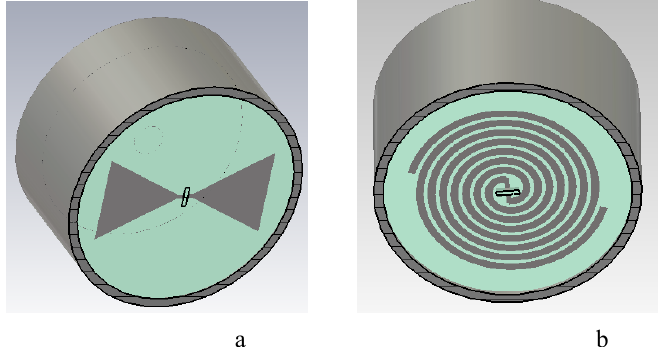
Fig. 2 . 3D model of a symmetrical dipole with triangular shoulders placed in a cylindrical housing (a); 3D model of a spiral antenna placed in a cylindrical housing (b).